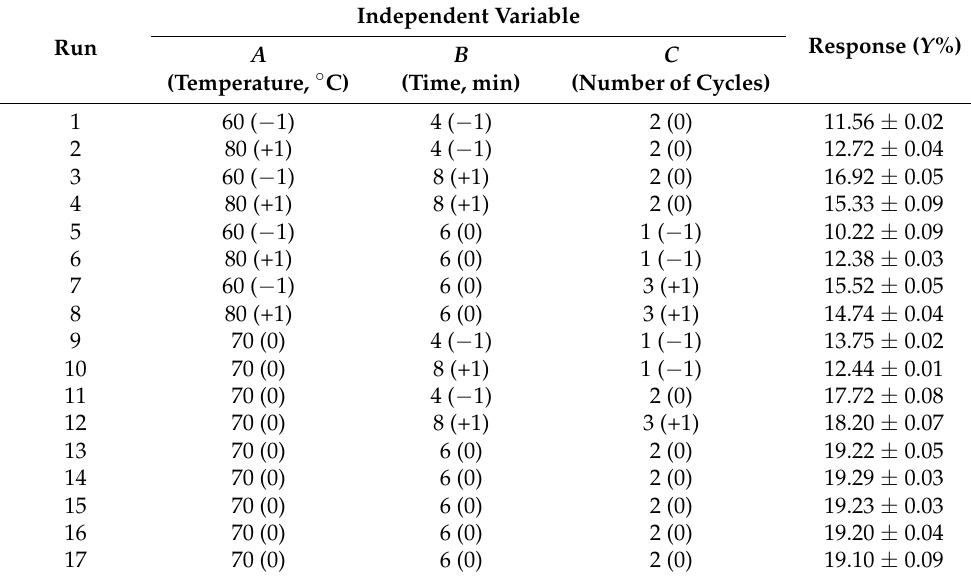
Table 2. Box–Behnken design and observed responses a .